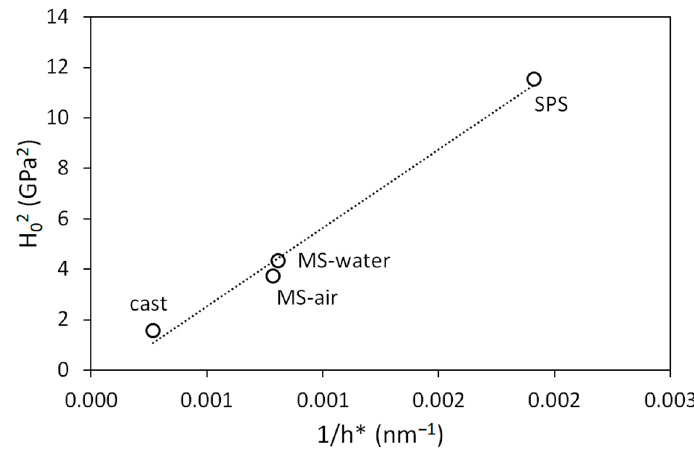
Figure 6. H 02 vs. 1/ h* dependency of CoCrFeMnNi samples. Figure 6. H 0 2 vs. 1/ h* dependency of CoCrFeMnNi samples.